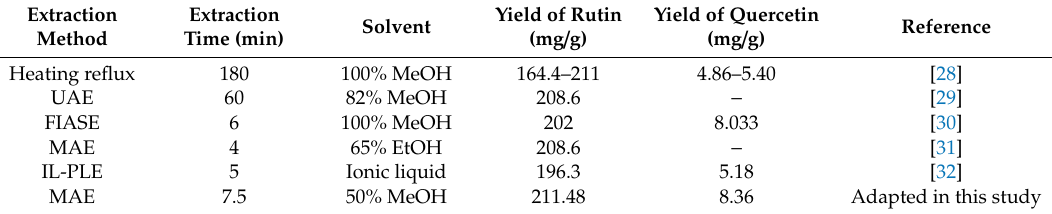
Table 7. The comparison of microwave-assisted extraction and other existing extraction methods.